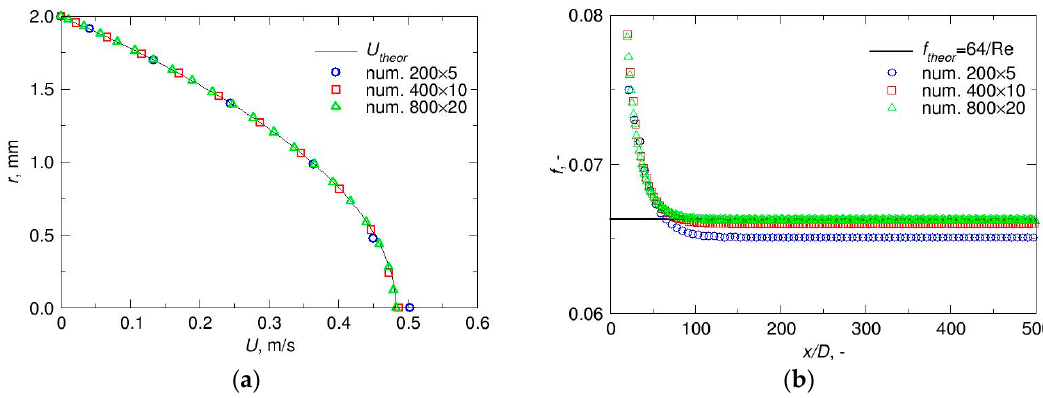
Figure 3. Results for laminar flow of water at Re = 965: ( a ) The computed velocity profile evaluated at x / D = 625; ( b ) The computed friction factor.